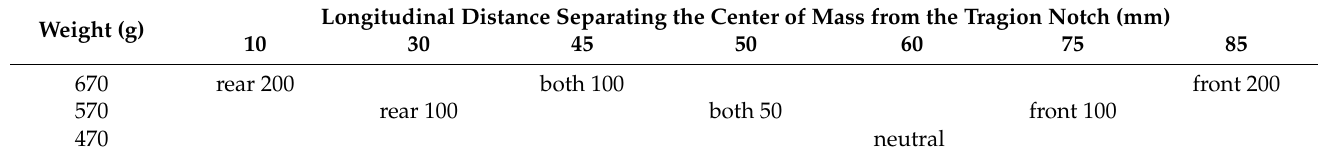
Table 1. Weight and balance conditions.